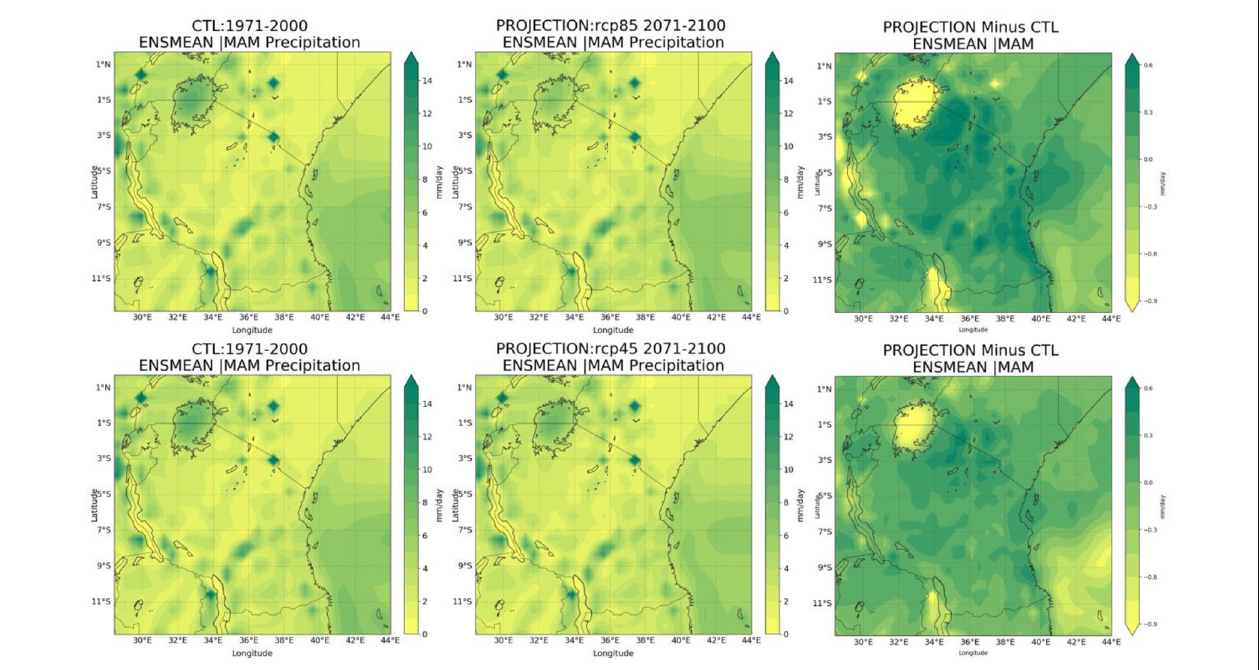
FIGURE 17 | Precipitation in mm/day for MAM during base period (1971–2000), mid century (2041–2070), and change in precipitation under both RCP8.5 (upper) and RCP 4.5 (lower)